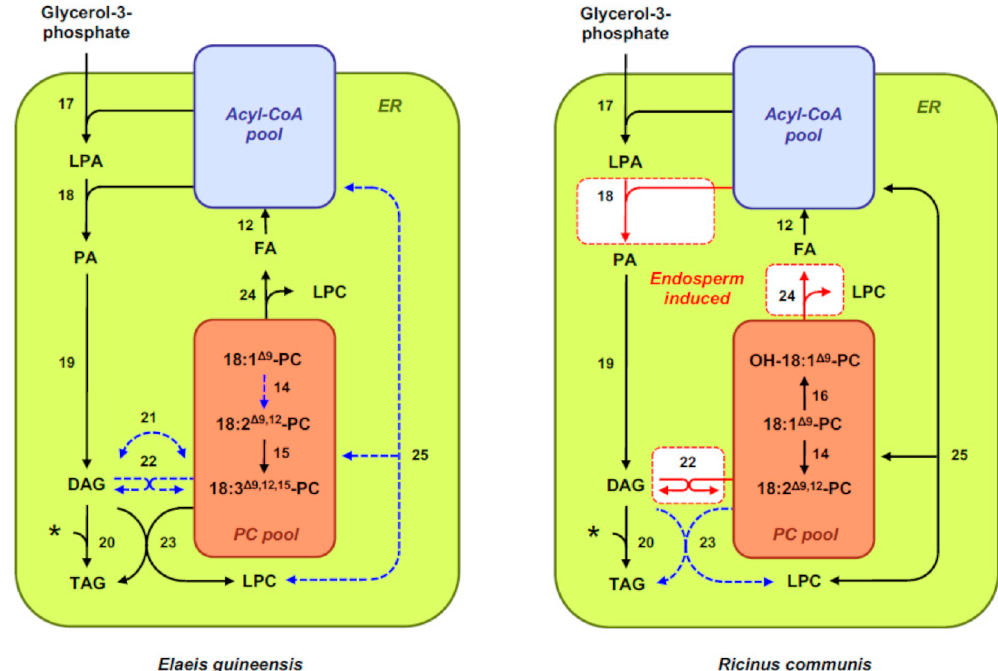
Figure 2. Overview of oil metabolism in maturing seeds of Elaeis guineensis and Ricinus communis . The scheme depicts the different pathways involved in the assembly of storage lipids in maturing seeds. Enzymatic steps transcriptionally induced in the endosperm with respect to the embryo are denoted in red and highlighted in white boxes. Blue dashed arrows denote enzymatic steps transcriptionally repressed in the endosperm. 12, long-chain acyl-coenzyme A synthetase; 14, ∆ 12 fatty acid desaturase; 15, ∆ 15 fatty acid desaturase; 16, ∆ 12 fatty acid hydroxylase; 17, acyl-coenzyme A: sn - glycerol-3-phosphate acyltransferase; 18, acyl-coenzyme A:lysophosphatidic acid acyltransferase; 19, phosphatidic acid phosphohydrolase; 20, acyl-coenzyme A:1,2-diacyl- sn -glycerol acyltransferase; 21, CDP-choline:1,2- sn -diacylglycerol choline phosphotransferase; 22, phosphatidylcholine:1,2- sn -diacylglycerol choline phosphotransferase; 23, phospholipid:1,2- sn - diacylglycerol acyltransferase; 24, phospholipase A 2 ; 25, acyl-coenzyme A: lysophosphatidylcholine acyltransferase. Abbreviations and symbols: *, acyl-CoA; CoA, coenzyme A; DAG, diacylglycerol; ER, endoplasmic reticulum; FA, fatty acid; LPA, lysophosphatidic acid; LPC, lysophosphatidylcholine; PA, phosphatidic acid; PC, phosphatidylcholine; TAG, triacylglycerol; VLCFA, very-long-chain fatty